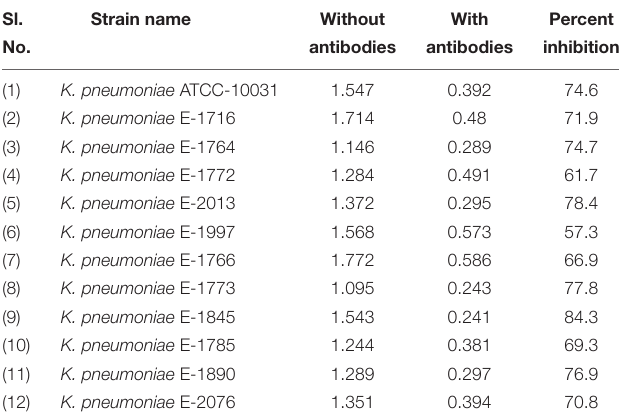
TABLE 4 | Biofilm inhibition assay on K. pneumoniae by OmpAK36 antibodies. Sl.